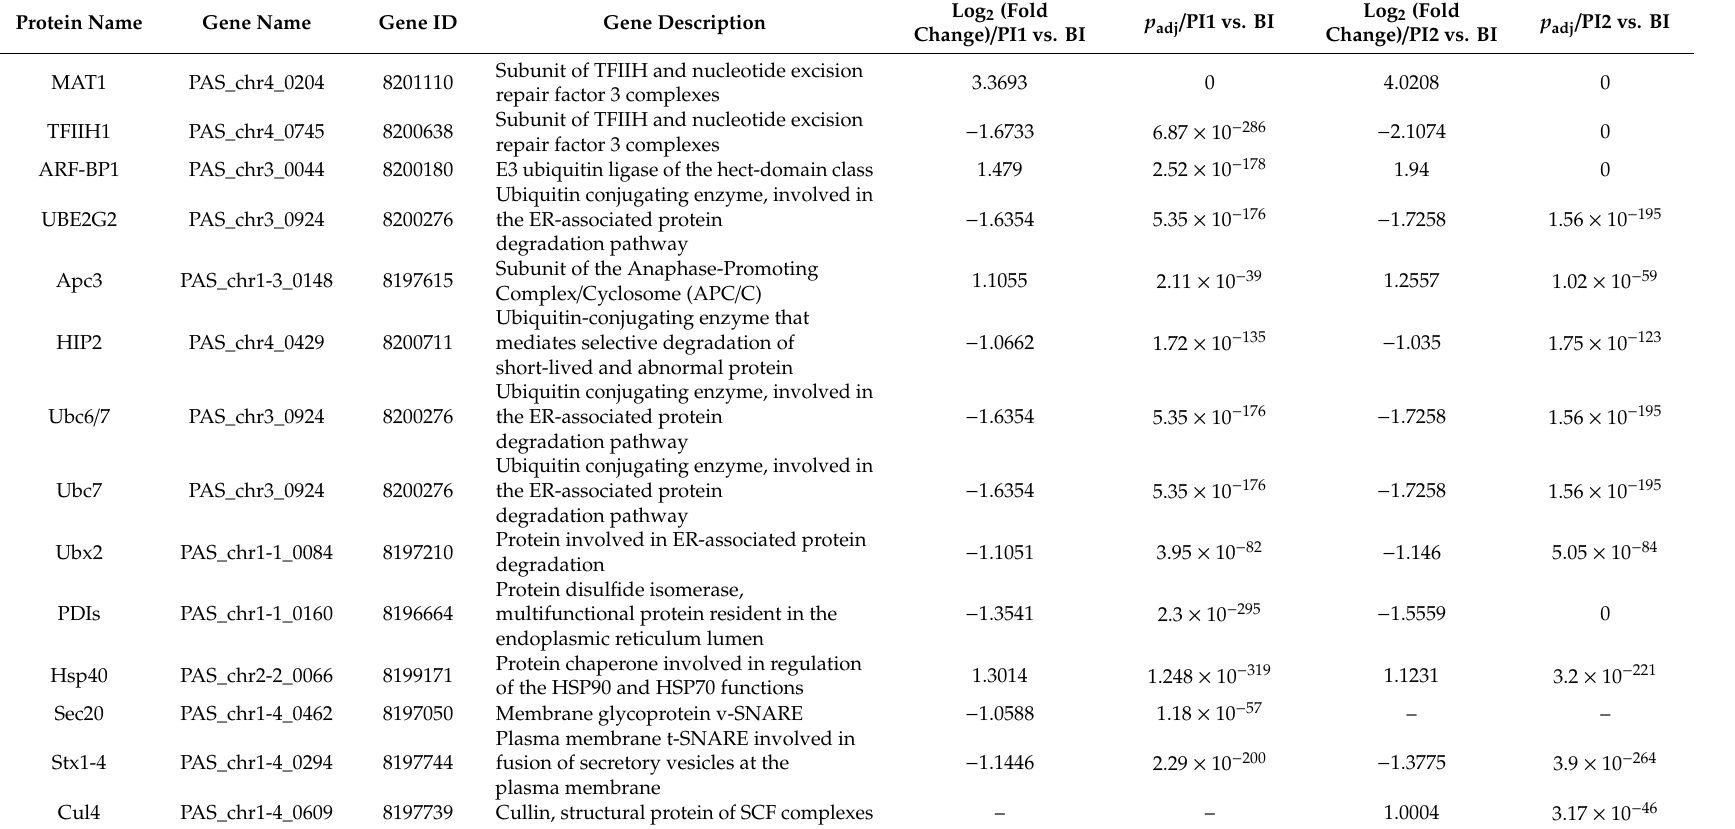
A dash line indicates no significant change in comparison to